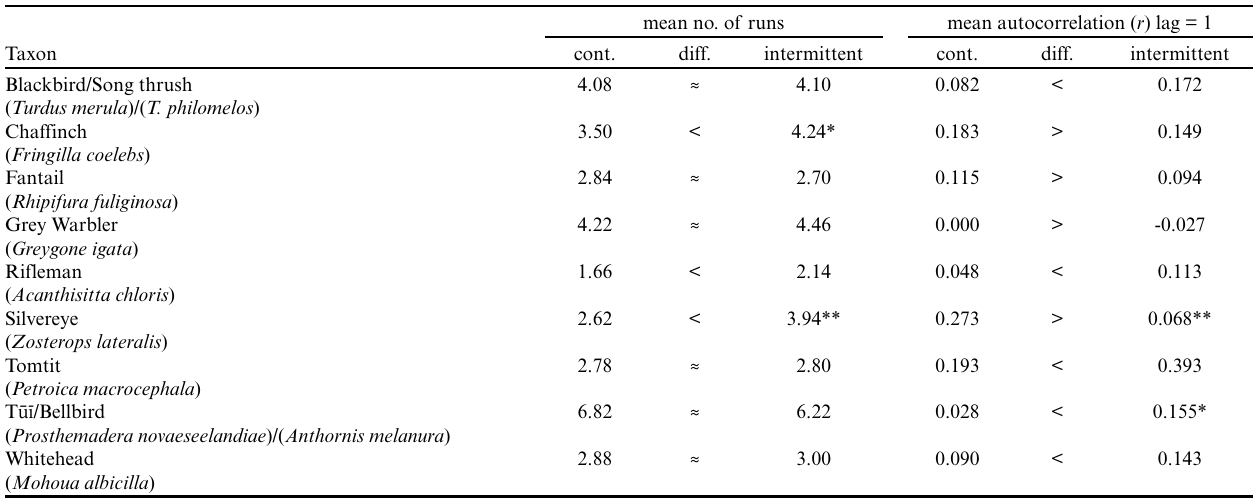
Table 1 . Comparison of the temporal structure of calls for different bird species sampled according to two different schemes (i) cont. = a continuous five minutes divided into 10-second subsamples and (ii) intermittent = the first 10 seconds of each minute from 30 minutes of recording. In both cases, 30 subsamples are scored for presence/absence per sample (n = 50). Diff. = differences, where, ≈ approximately equal (within 10% of the lower value), > continuous method at least 10% greater than intermittent method, < continuous method at least 10% less than the intermittent method. * indicate significant differences where P < 0.05, ** indicate significant differences at P < 0.005. Mean number of runs were compared with a paired Student’s t-test, autocorrelation (lag 1) was compared with an unpaired two sample t-test because of an unequal number of trivial (nonempty) samples per